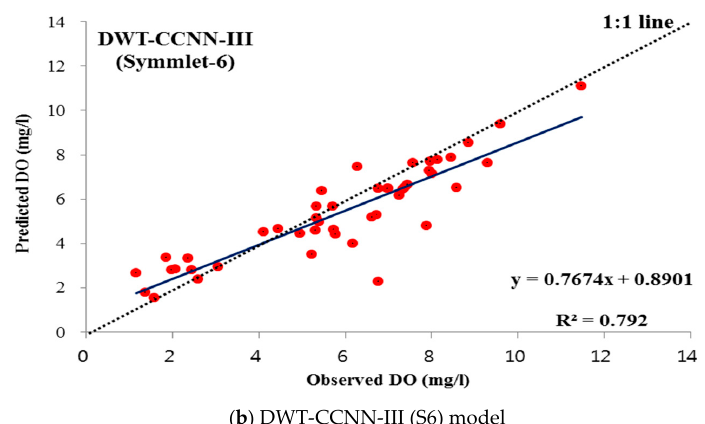
Figure 10. Scatter plots of observed and predicted DO values using DWT-based soft computing models for the testing phase.